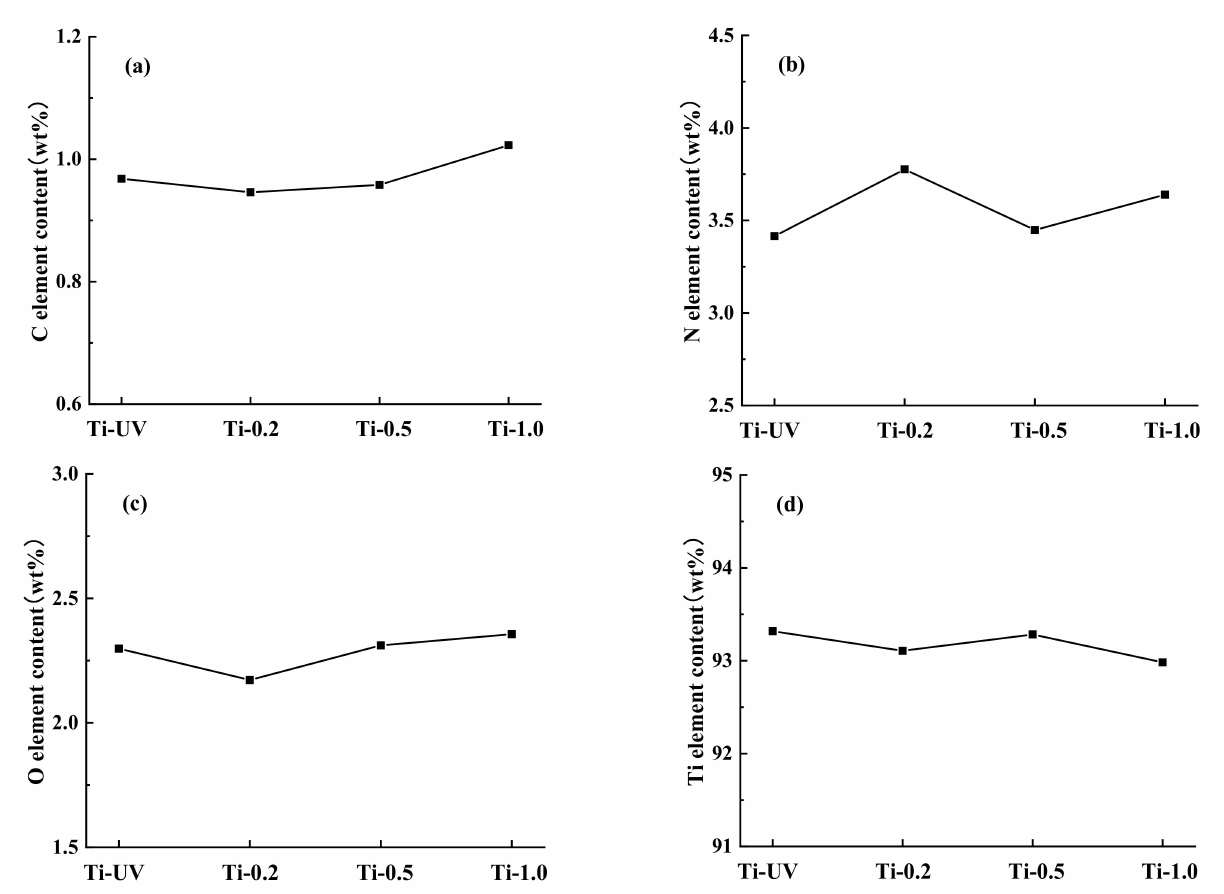
Figure 2. Element content of different samples: ( a ) carbon; ( b ) nitrogen; ( c ) oxygen; ( d )